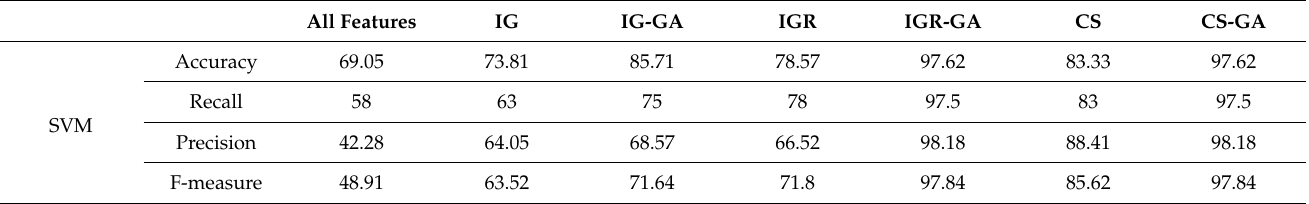
Figure 5. The accuracy comparison of classifiers using all features, the features selected only by filters methods, and the features selected by the proposed hybrid filter-GA methods on the CNS dataset. Table 3. The performance comparison of classifiers using all features, the features selected by filters methods, and the features selected by the proposed hybrid filter-GA methods on the Brain